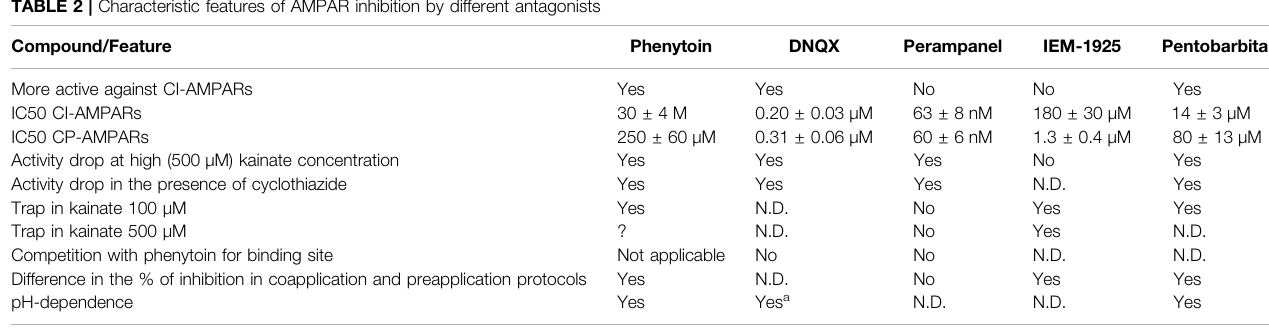
TABLE 2 | Characteristic features of AMPAR inhibition by different